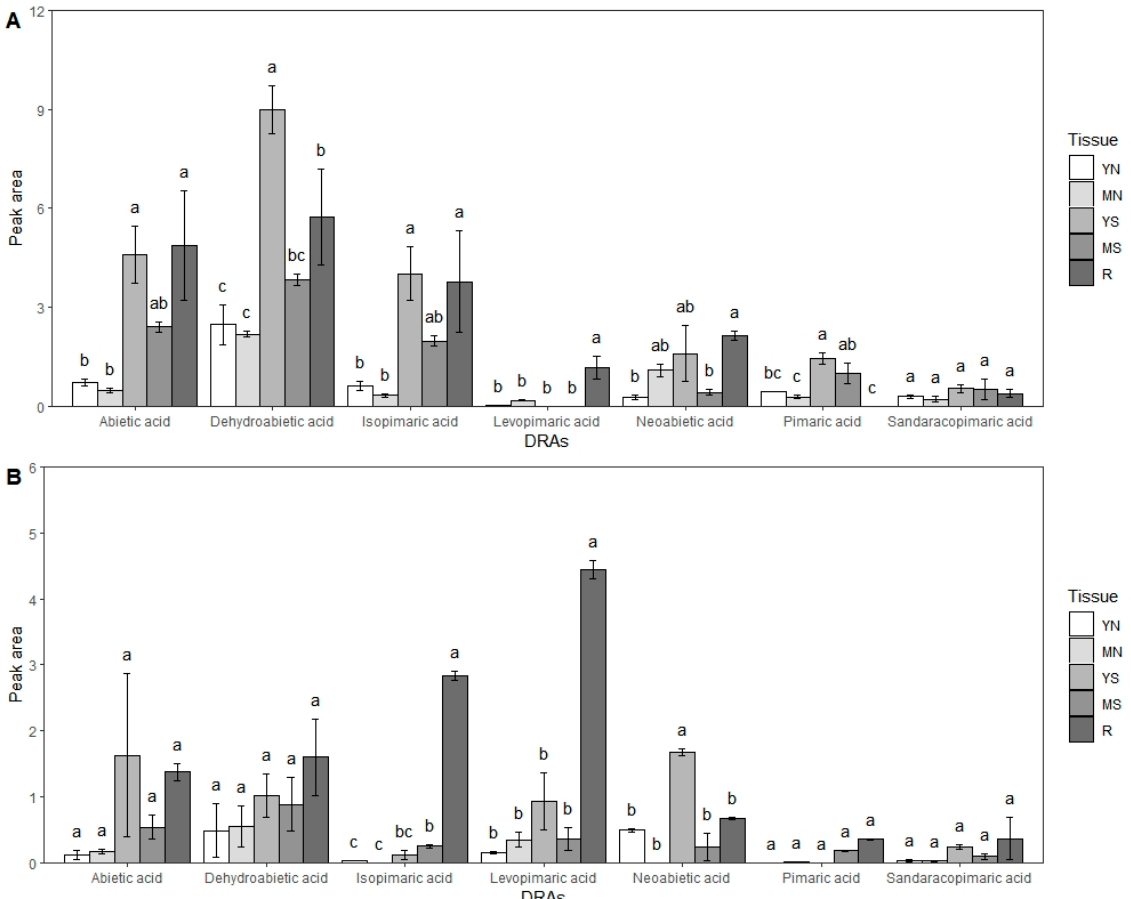
Figure 6. DRAs content in different tissues. ( A ) DRA content of tissues in slash pine; ( B ) DRA content in different tissues in loblolly pine. Error bars represent standard deviation values of biological replicates ( n = 3). Statistically significant differences are indicated with different letters (Tukey’s test, p < 0.05). YN represents young needles, MN represents mature needles, YS represents young stems, MN represents mature stems, and R represents roots.